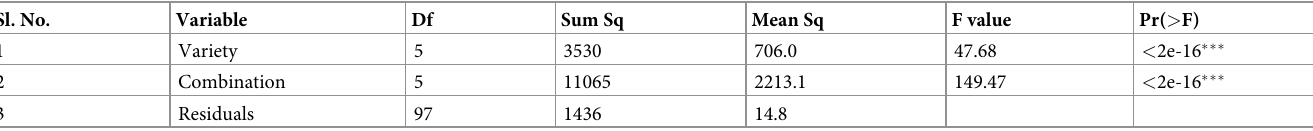
Table 10. ANOVA results for effect of different carbon sources on green shoot regeneration. Sl. No.